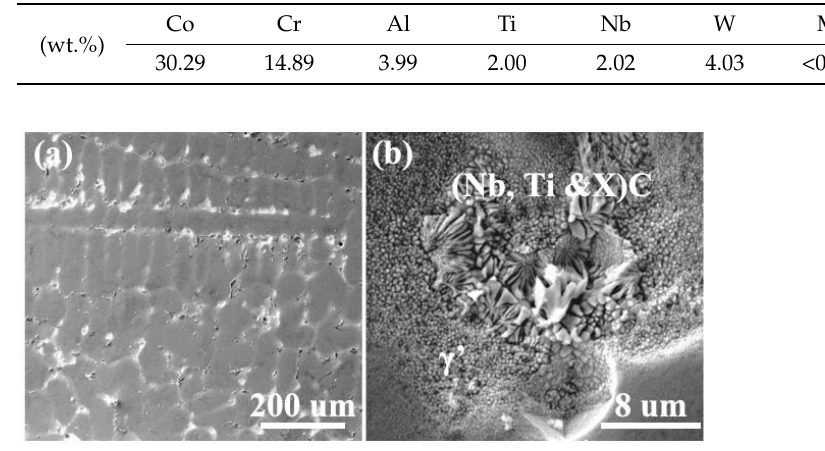
Figure 1. The microstructure of the SJTU-1 alloy in ( a ) OM and ( b ) SEM. The relationship between fraction liquid and temperature of SJTU-1 alloy calculated by ProCAST (ESI Group, Version 2019) and JMatPro is shown in Figure 2. It can be concluded that the minimum eutectic temperature (solidus temperature) is in the range of 1165–1195 °C, less than 1200 °C.